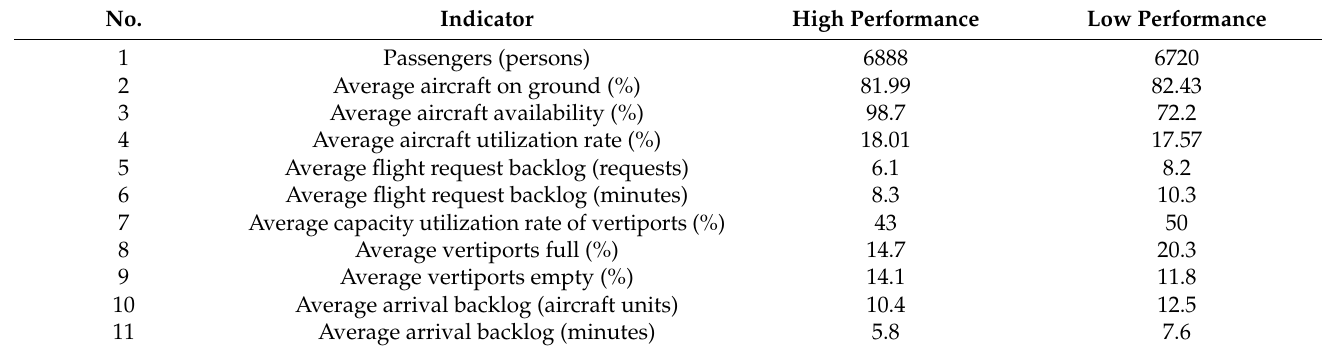
Table 2. Simulation results for maintenance factor in a high demand level scenario.